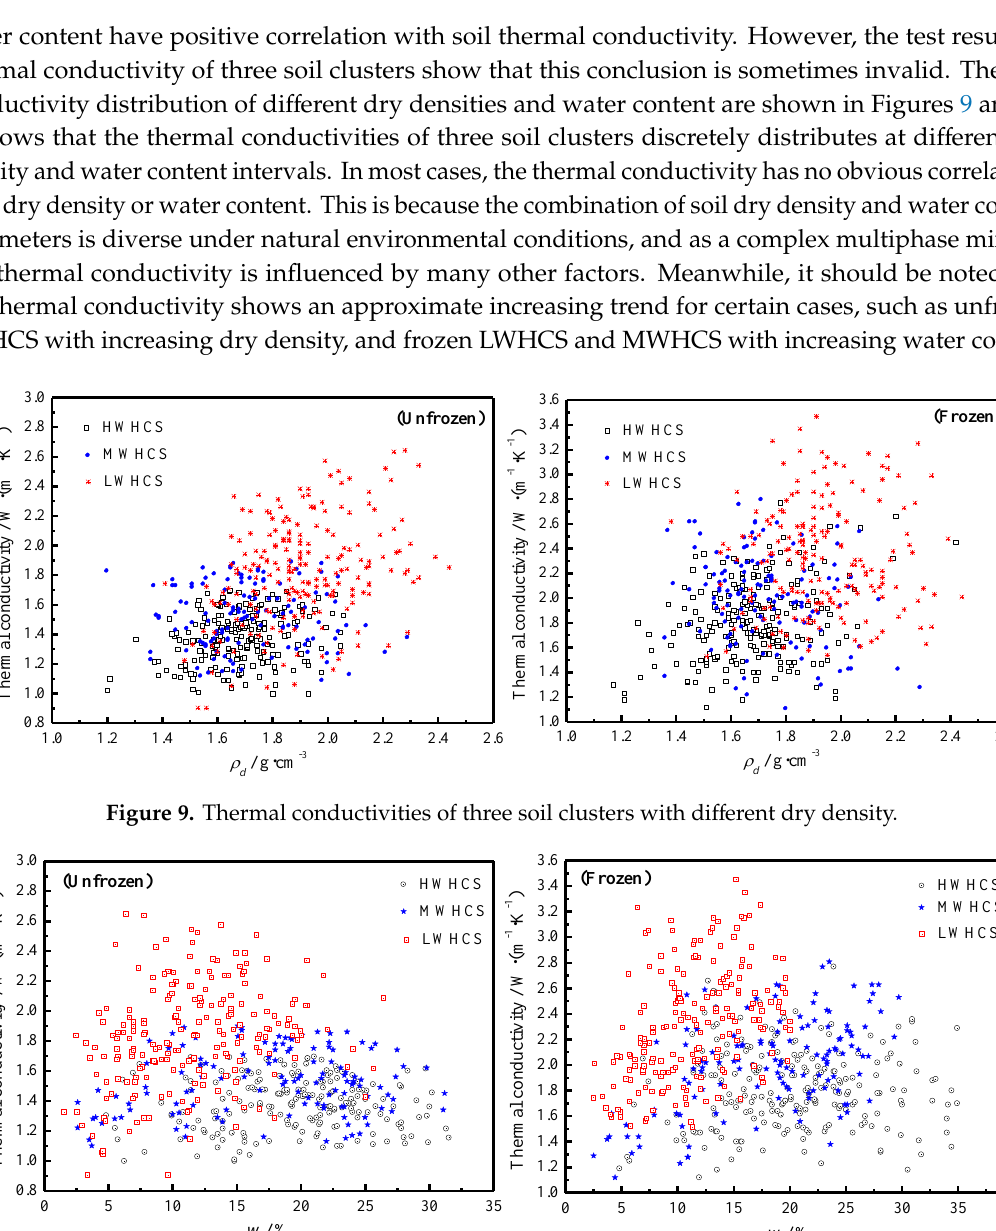
Figure 8. ( a ) Dry density and ( b ) water content cumulative proportion of three soil clusters.